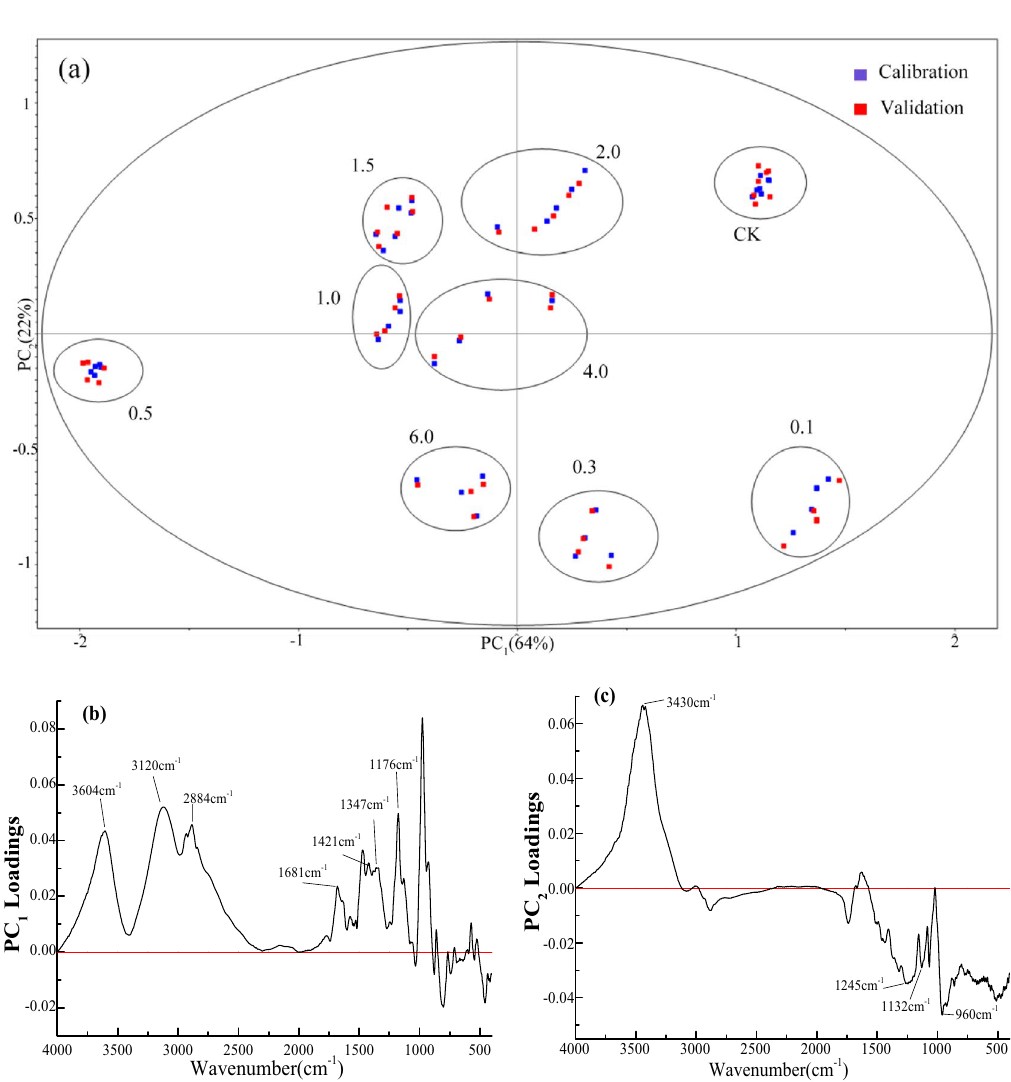
Figure 3. PCA scores plot of FTIR spectra of M. oleifera roots cultivated at different concentrations of Na 2 SeO 3 : ( a ) PCA scores plot; ( b ) PC 1 loadings plot; ( c ) PC 2 loadings